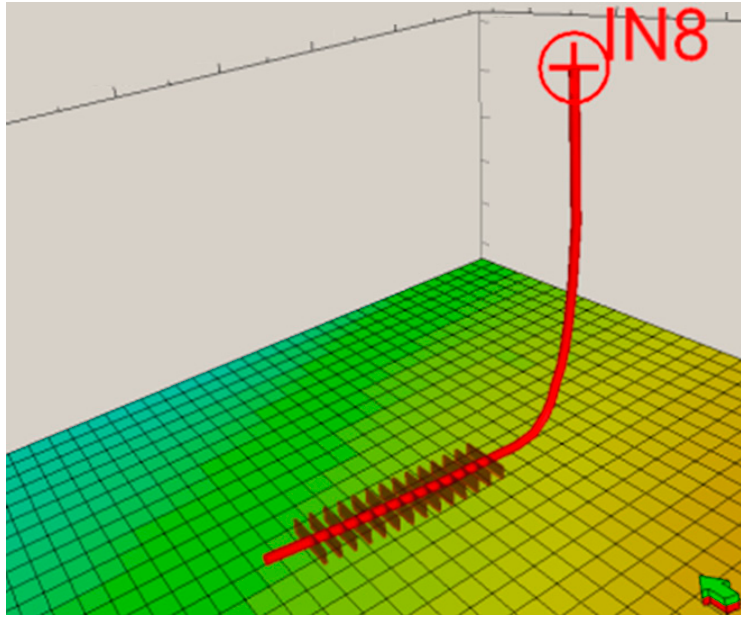
Figure 3. Horizontal borehole with hydraulic fracturing.